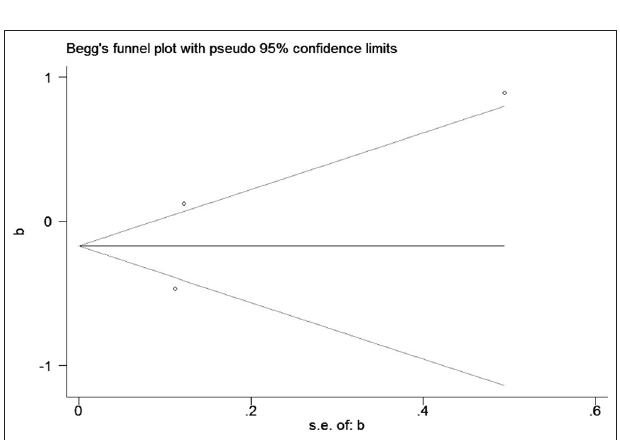
FIGURE 9 | The funnel plot of TCS exposure during childhood and children’s